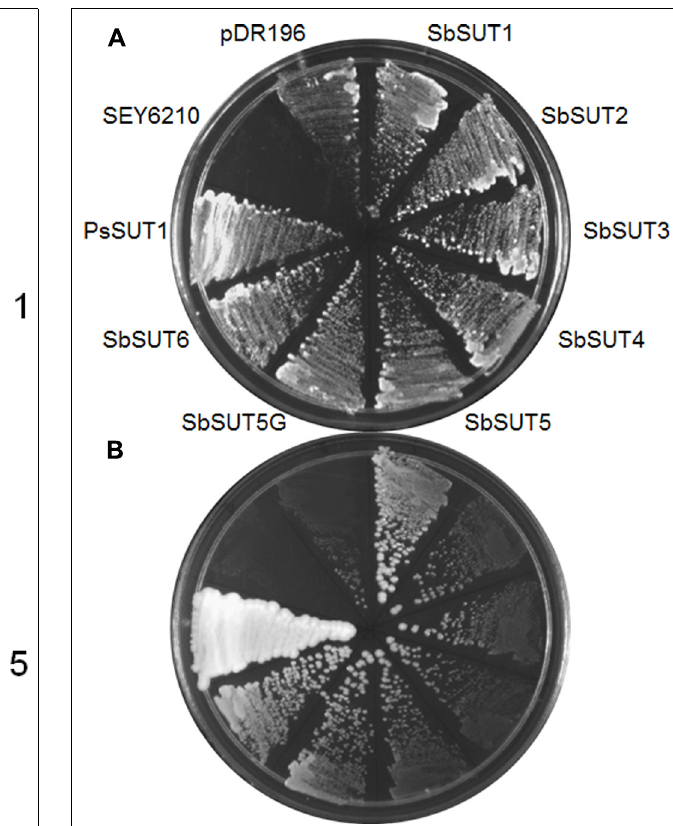
FIGURE 4 | Complementation of the SEY6210 yeast strain by Sorghum SUTs. All Sorghum SUTs were expressed in the yeast strain SEY6210 and grown on media containing (A) 100 mM glucose or (B) 25 mM sucrose as the sole carbon source. SuSy7 containing PsSUT1 was used as a positive control.The SuSy7 PsSUT1-pDR195 (Zhou etal., 2007) was used as a positive control and negative controls were untransformed SEY6210 and pDR196 empty